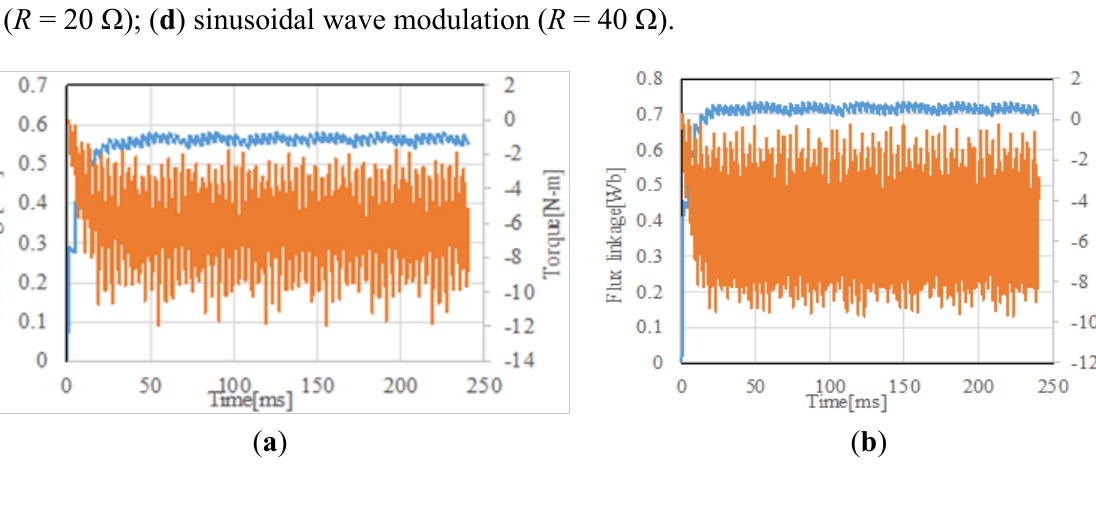
Figure 14. Flux linkage and torque wave form at 1800 rpm. ( a ) Triangular wave